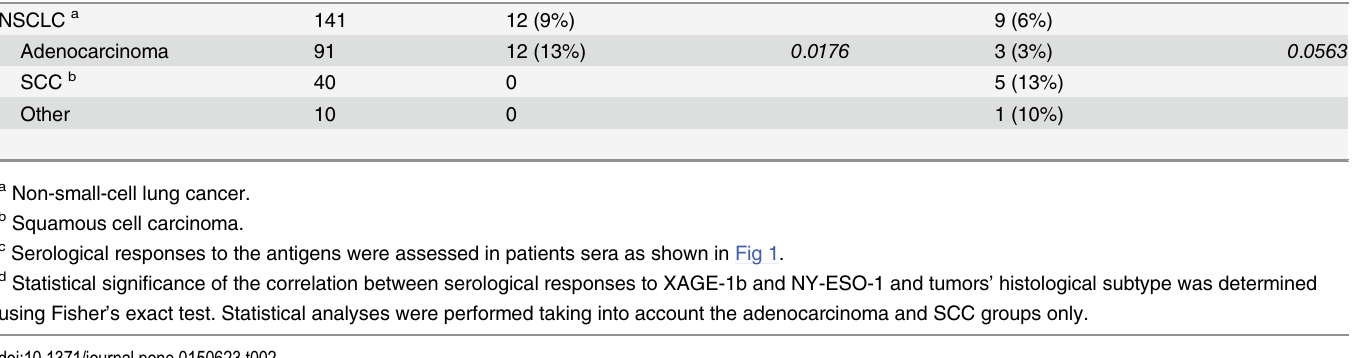
1:100. We detected significant serological responses to XAGE-1b in 12 patients (Fig 1A). In